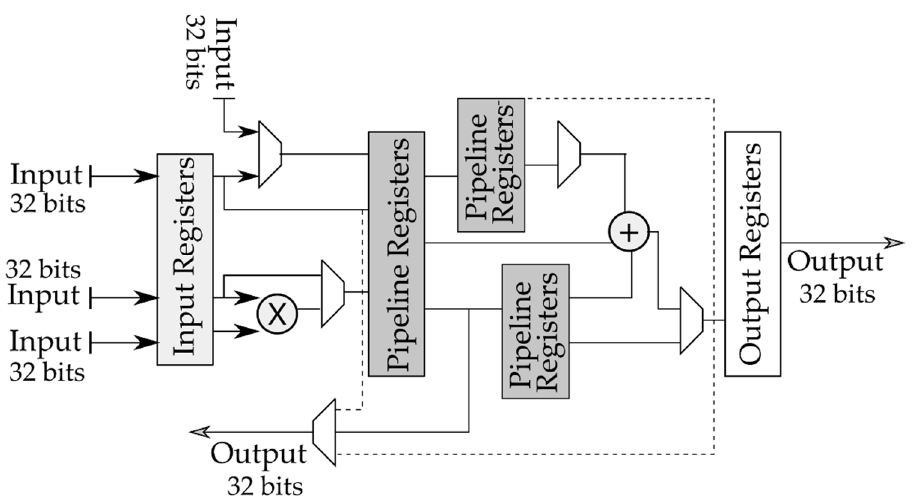
Figure 6. Single-precision floating-point mode (adapted from © [15]). Table 2. Cycle numbers to execute an instruction.